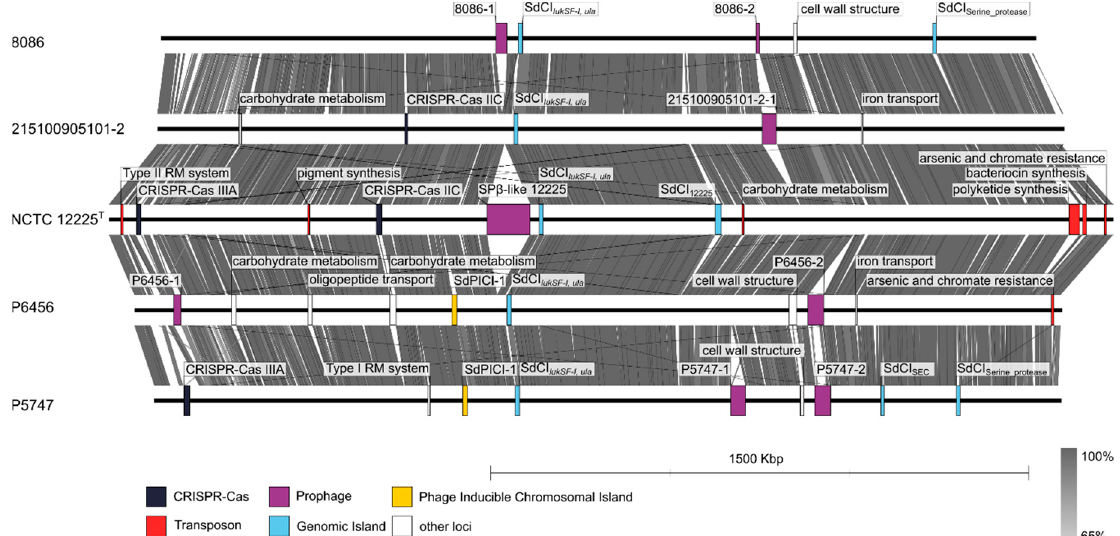
Figure 5. Whole-genome comparison of Staphylococcus delphini penguin isolates P5747 (GenBank accession no. WNLD00000000) and P6456 (WNLE00000000) with horse strains 8086 (CAIA00000000), 215100905101-2 (MWUT00000000), and type strain NCTC 12225 T from a dolphin (LR134263). Genomic regions with major differences between neighboring genomes and significant mobile genetic elements are highlighted in rectangles and are color-coded according to the legend. Prophage genomes 8086-1, 8086-2, and P6456-1 were located on different contigs, and therefore are not complete in the whole-genome comparison. Conserved regions with more than 65% homology are indicated with different shades of grey as determined by blastn.